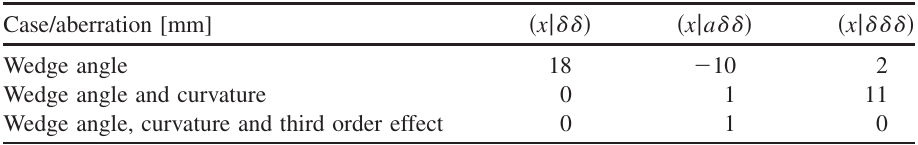
TABLE II. Some map elements that illustrate the effect of the higher order shape of the wedge on the map. The numerical values correspond to a 200 MeV = u 132 Sn beam incident on an aluminum degrader of thickness equal to 30% of the tin beam